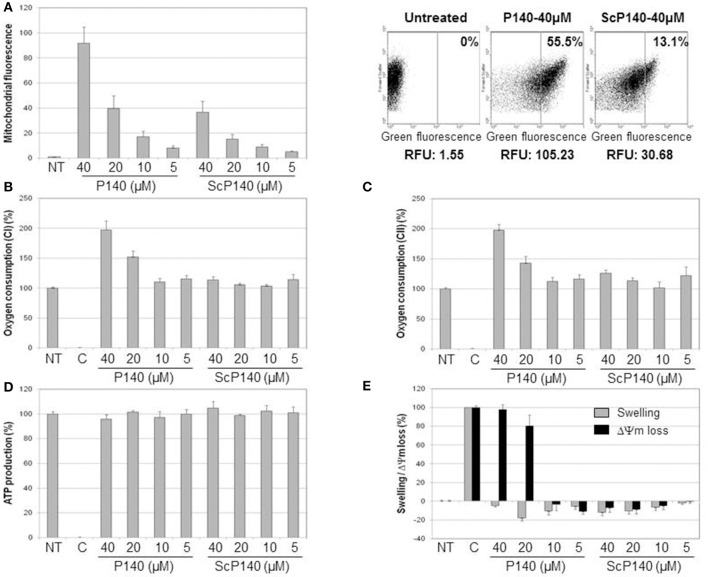
Direct effect of P140 peptide on mitochondria isolated from Raji cell line. (A) Mitochondrial targeting was estimated by flow cytometry after incubation of increasing concentrations of AF488-P140 and ScP140 peptides with isolated mitochondria. Left panel: mitochondrial labeling was expressed in fluorescence ratio in function of mitochondrial basal fluorescence (Untreated; mitochondria without peptide). Right panel: relative mitochondrial fluorescence with or without incubation with AF488-peptides. The percentage of highly labeled mitochondria (right section) and relative fluorescence unit were indicated for each sample. (B,C) Oxygen consumption in the presence of malate, glutamate and ADP (B) or succinate (C) was measured with or without increasing concentrations of P140 and ScP140 peptides. Results were normalized on both untreated mitochondria (100% of oxygen consumption) and inhibition control (rotenone for complex I and oligomycin A for complex II; 0% of oxygen consumption). (D) ATP production of mitochondria in the presence of succinate and ADP was measured with or without increasing doses of P140 and ScP140 peptides. Results were normalized on both untreated mitochondria (100% of ATP production) and inhibition control (malonate; 0% of ATP production). (E) Mitochondrial swelling (gray bars) and potential loss (ΔΨm loss; black bars) were measured with or without increasing concentrations of P140 and ScP140 peptides. Results were normalized on both untreated mitochondria (0% of swelling and ΔΨm loss) and control (Triton for 100% optical density decrease and carbonyl cyanide 3-chlorophenylhydrazone for 100% ΔΨm loss).